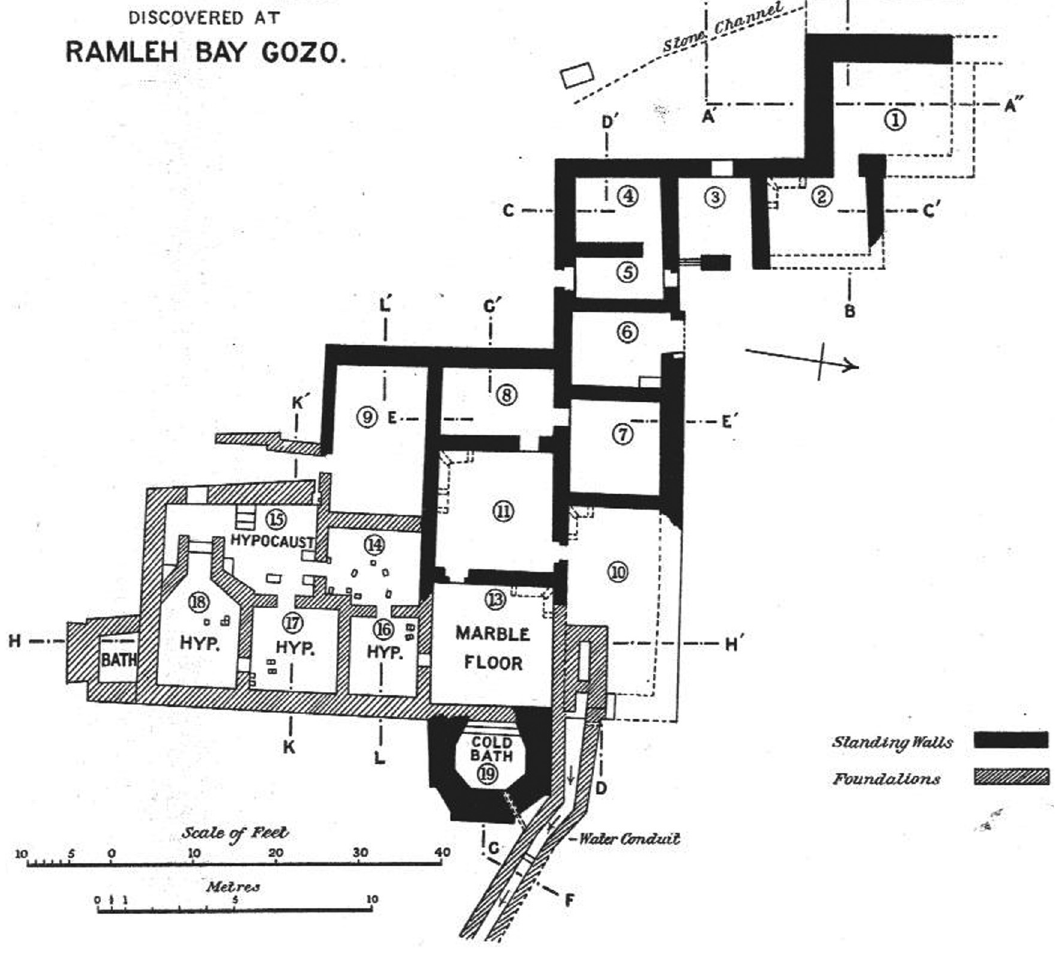
Figure 3: Plan of villa remains published by Ashby in